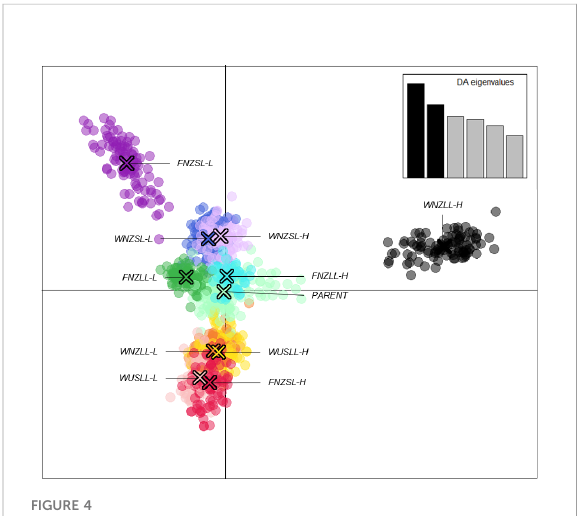
FIGURE 4 Discriminant analysis of principal components (DAPC) scatter plot of 1,113 individuals using 14,743 SNPs based on 11 assigned genetic clusters. Six principal components (Supplementary Figure 8) and six discriminant functions (DFs) were retained for analyses to describe the relationship between the genetic clusters. The scatter plot shows the fi rst two DF from the DAPC analysis (X and Y axis explaining 24.6% and 19.3% of genetic variance, respectively) with the scree plot of eigenvalues of the linear discriminant analysis (LDA) shown in the inset. Populations are labelled and colour coded at K = 11 as determined from the K -means clustering algorithm. Each dot represents a single individual and the centre of each cluster, as determined by a minimum spanning tree based on the squared distances between populations, is indicated by a